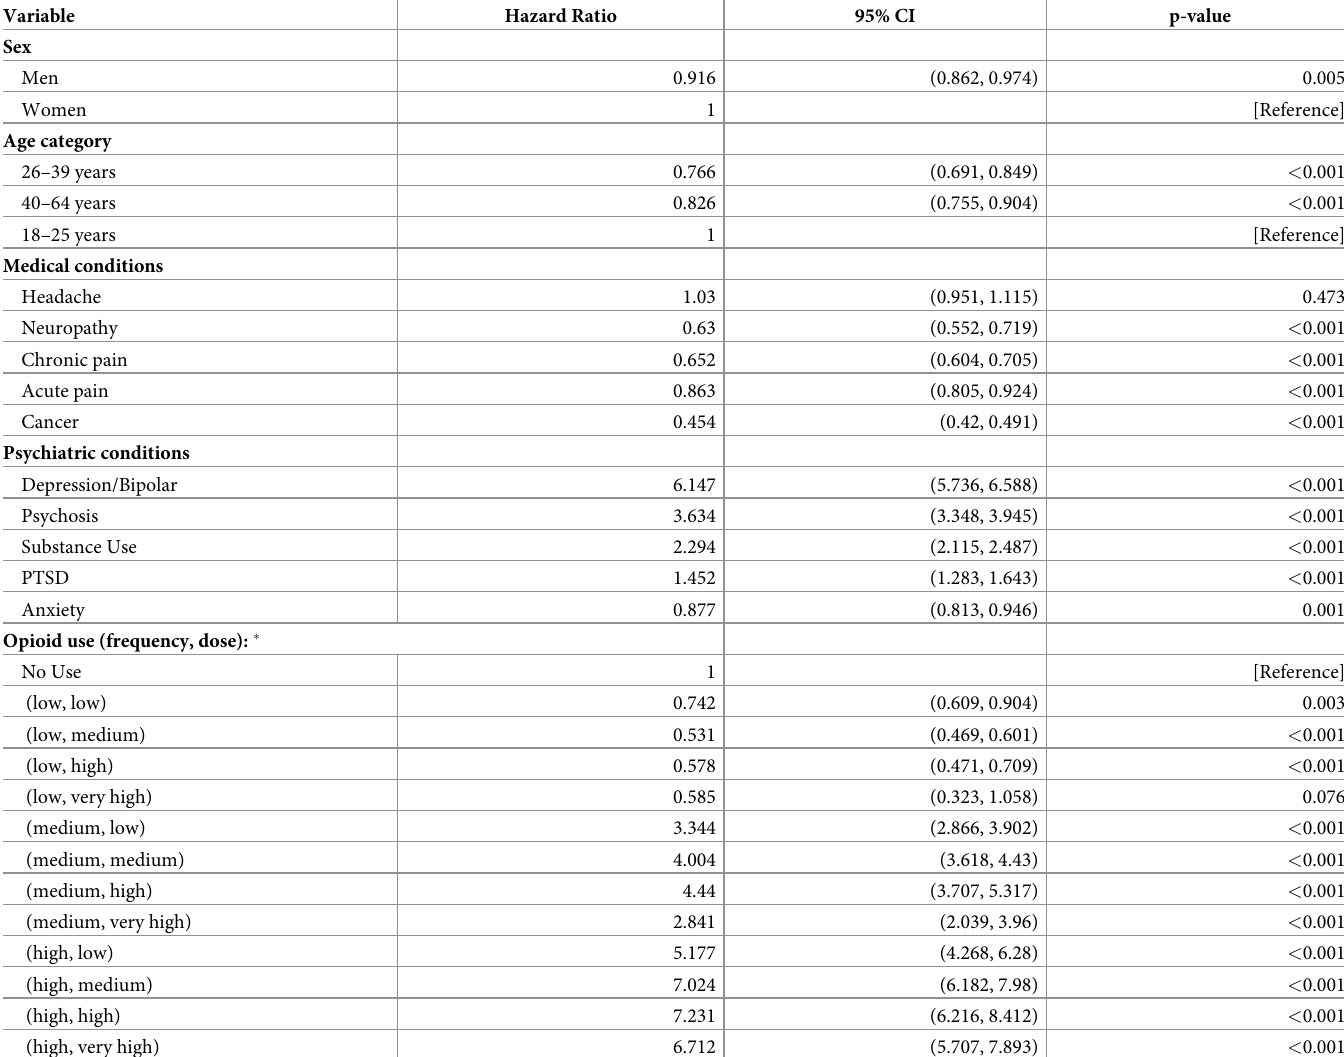
Table 2. Results of multivariable Cox regression for time to suicide attempts (N = 842,773).